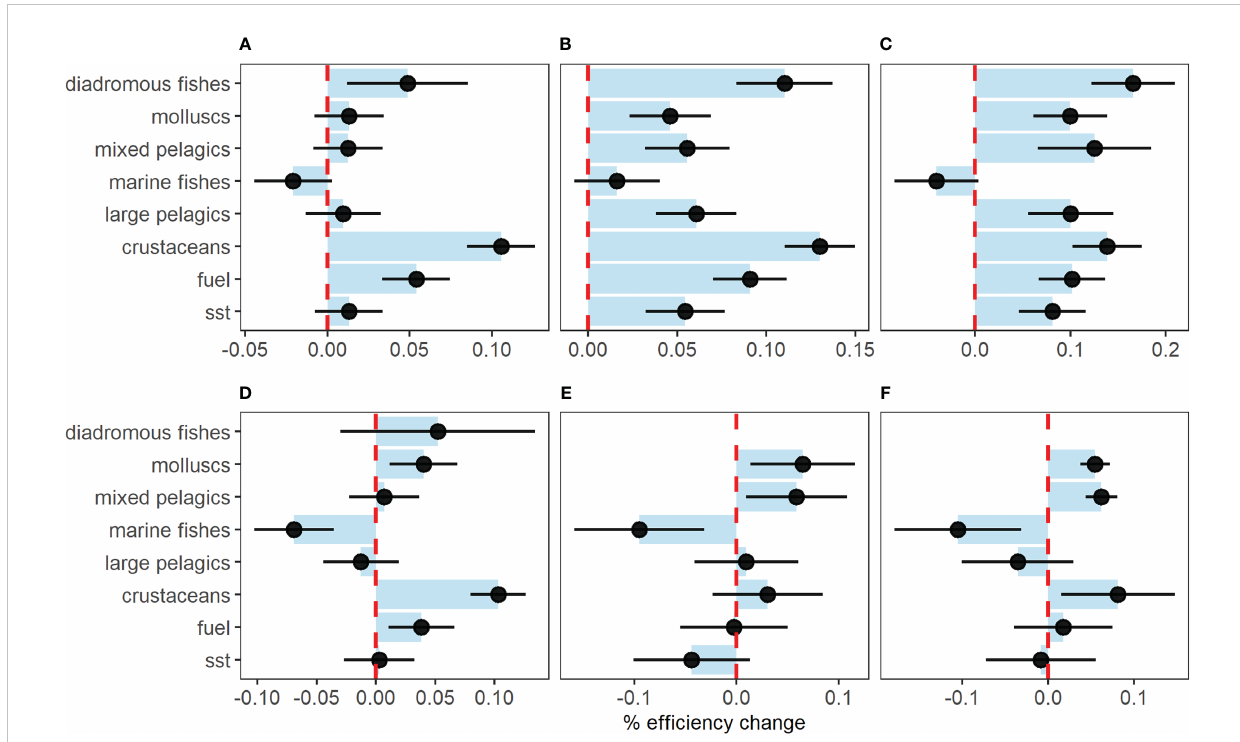
FIGURE 1 Maximum global elasticities by region. A 1% change in the exogenous predictor ’ s leads to a percentage change in technical ef fi ciency (y-axis) (black standard error bars). Each panel represent a different region: (A – F) Africa, Asia, Europe, North America, Oceania, and South America,